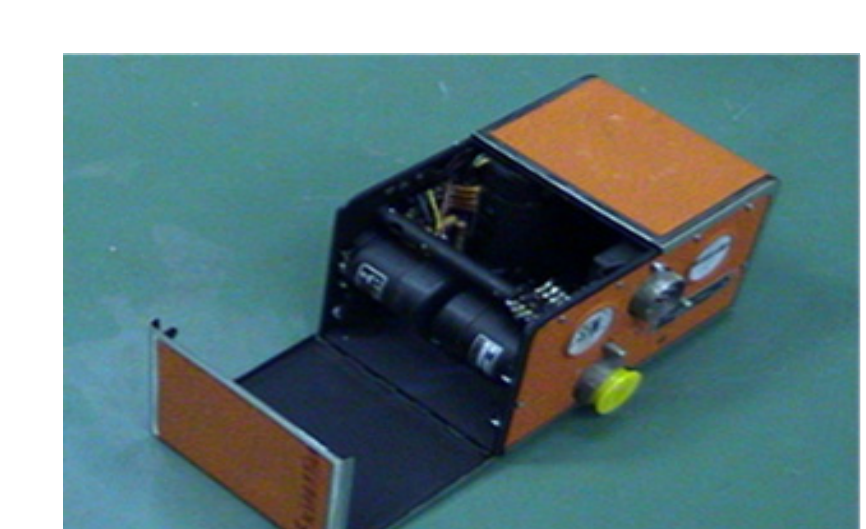
Figure 4 – A20 photo recorder (Arhiv Vazduhoplovnog opitnog centra, 2016) Рисунок 4 – Фоторегистратор A-20 (Arhiv Vazduhoplovnog opitnog centra, 2016)